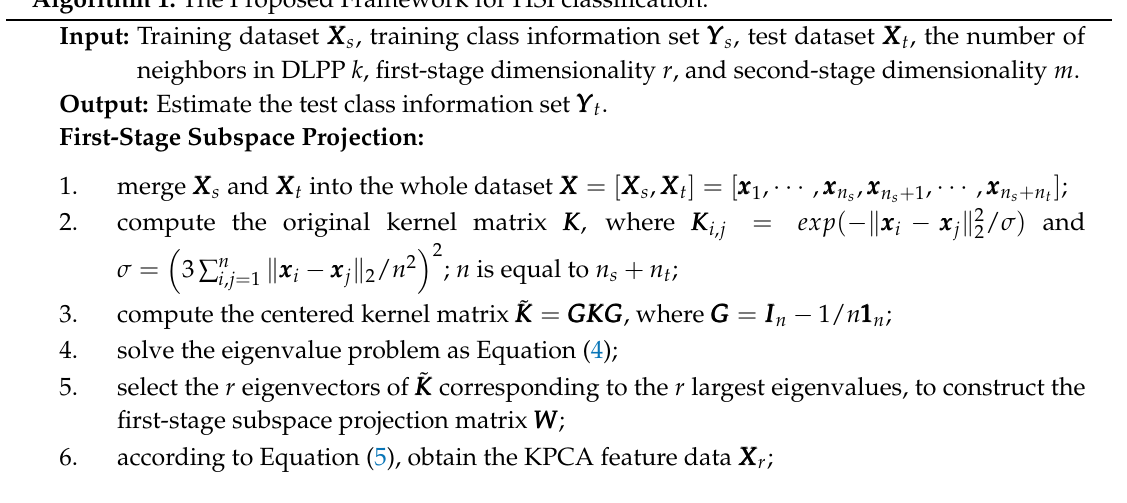
Algorithm 1: The Proposed Framework for HSI